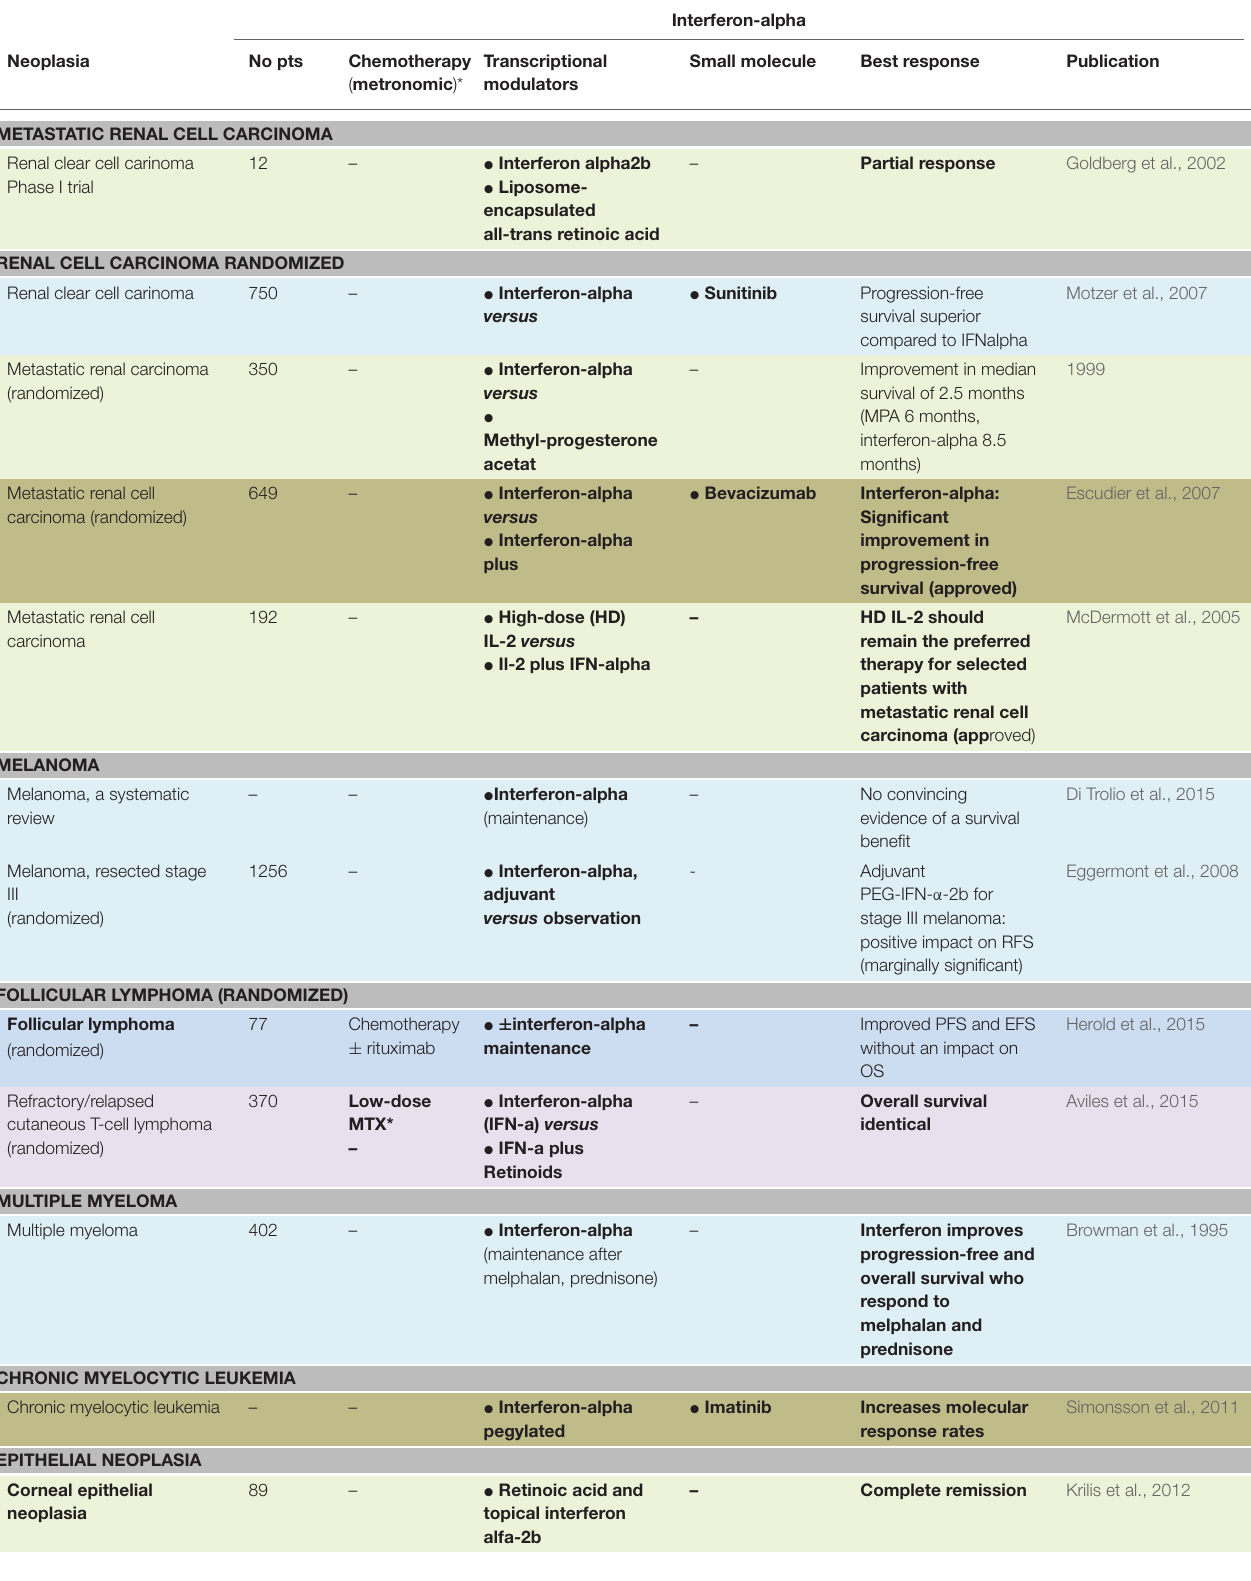
TABLE IV | Communicative reprogramming of tumor